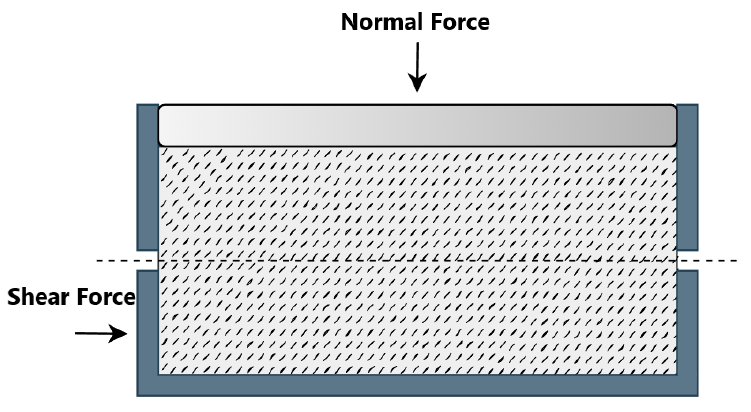
Figure 1. Flow chart of research process.